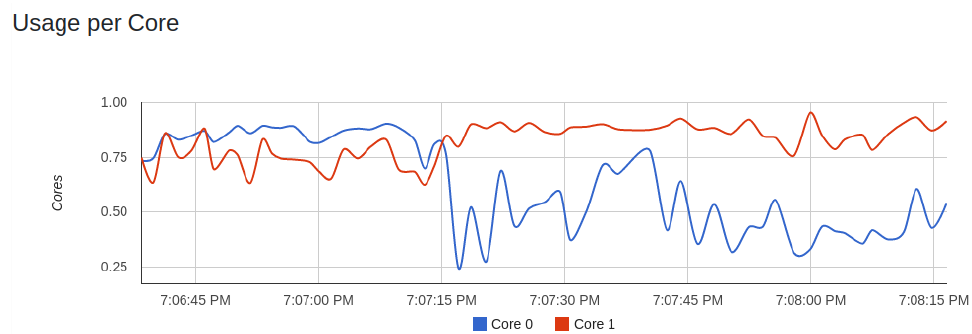
Figure 25. Confirmation of the CPU consumption when the DDoS attack